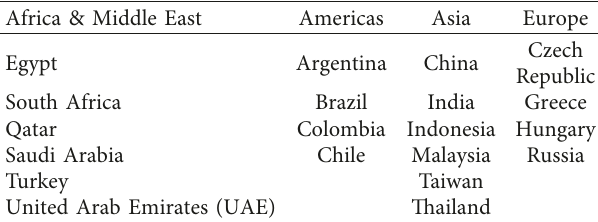
Table 1: Emerging Market Economies classification by